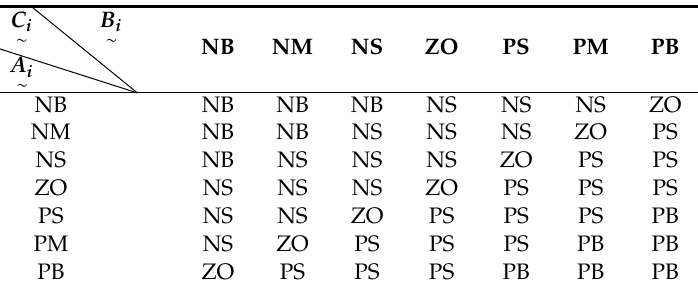
Table 1. Rule Table.